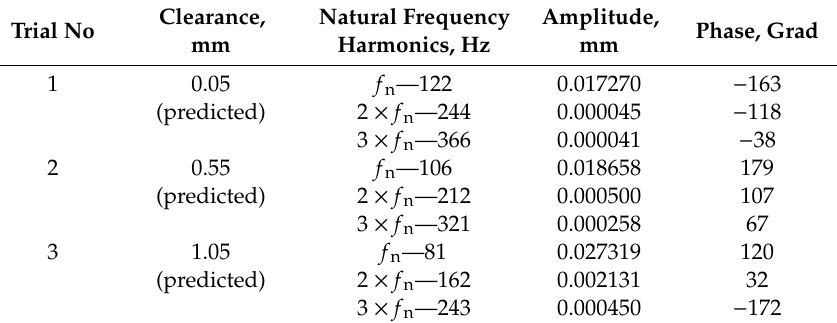
Table 3. Results of vibration measurements (Figure